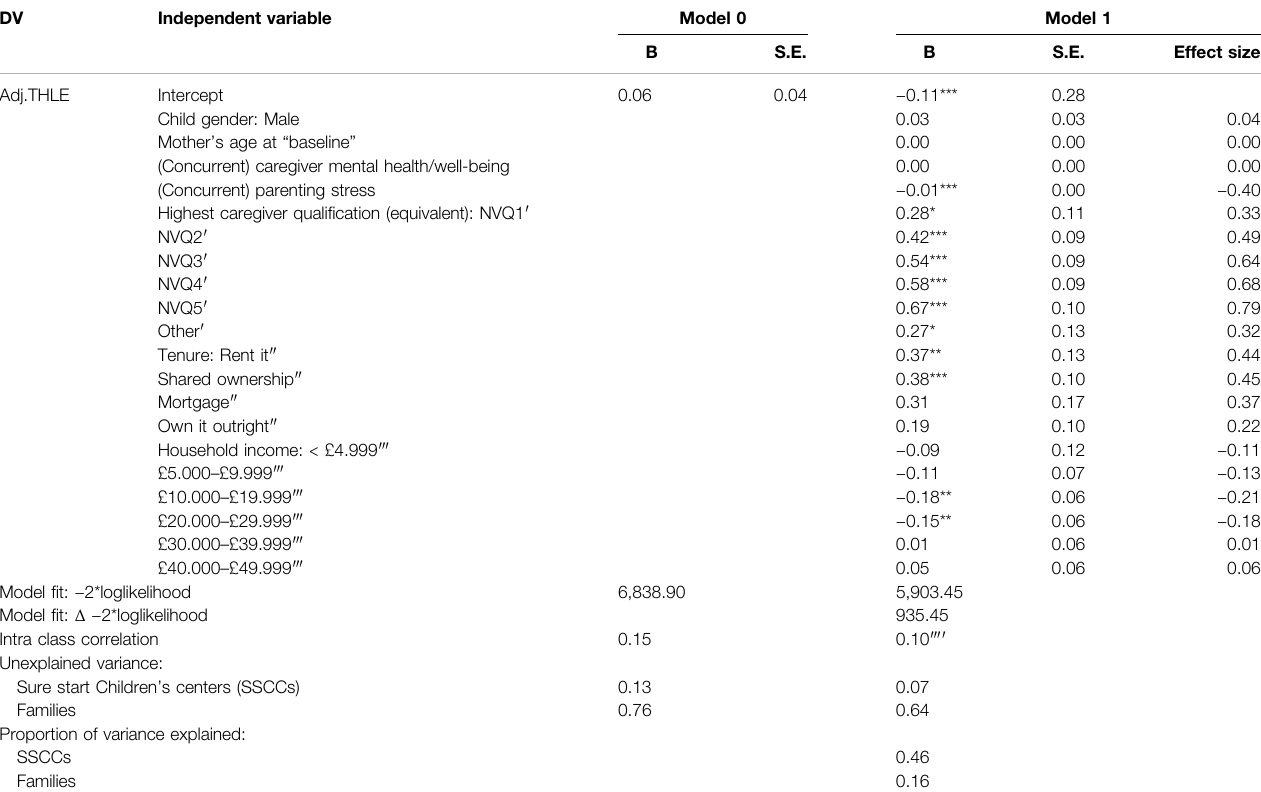
TABLE7| Multilevelregressionshowingassociationsbetweendemographicsandthechildage-adjustedToddlerHomeLearningEnvironmentScale(adj.THLE;n (cid:1) 2,404of the longitudinal n (cid:1) 2,608). DV Independent variable